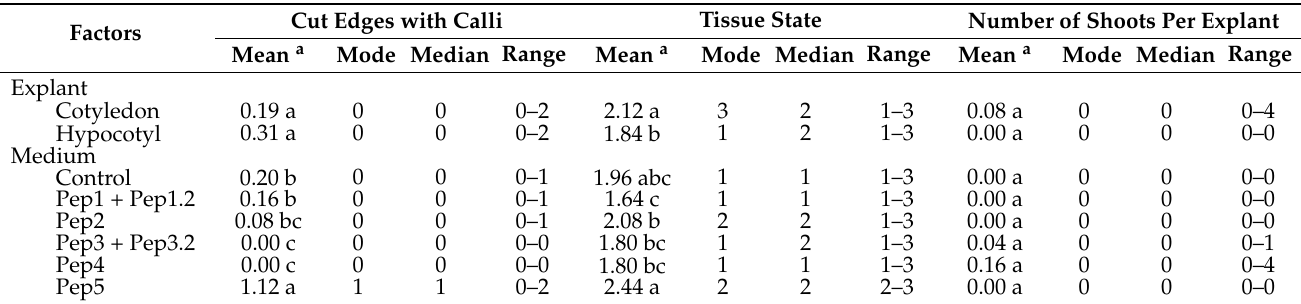
Table 5. Organogenesis of C. chinense explants. Mean, statistical significance (groups defined with lower-case letters, p < 0.05), mode, median and range of the number of cut edges with calli ( n ; after one month), the tissue state (measured on a 1–3 scale—1 = green tissue, 2 = dull greyish brown tissue; 3 = dead tissue—after two months) and the number of shoots per explant (n; after two months) depending on the type of explant (cotyledon and hypocotyl) and the medium used for regeneration. An experimental session was carried out with three replicates for each combination of factors (except cotyledon, for which only two replicates were made due to the lack of plant material) and five explants per plate. Factors